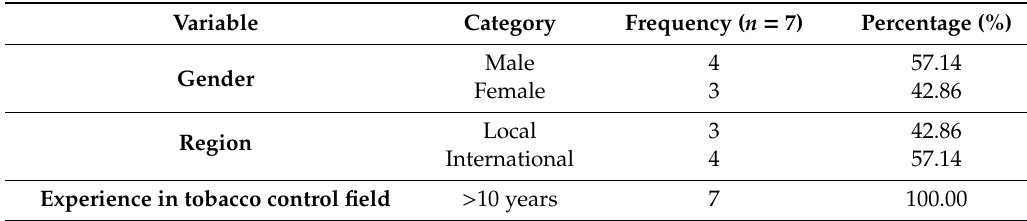
Table 2. Demographics of expert